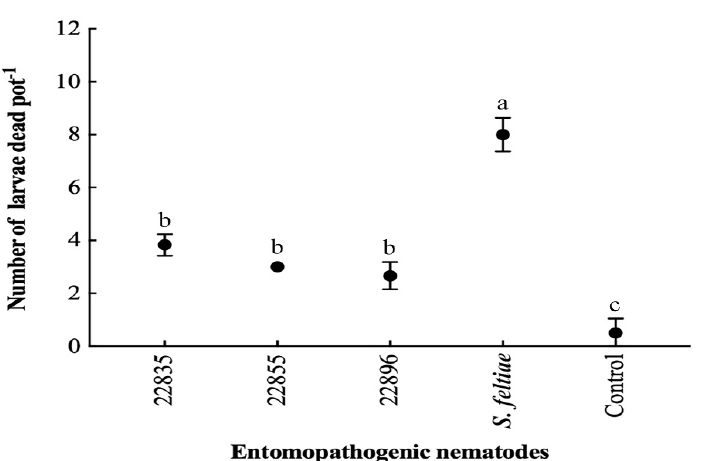
Figure 7. Mean number of dead larvae of the third-instar Spodoptera frugiperda in pot experiments after five days of different treatments (4800 IJs plant − 1 ). Bars with different letters represent signifi- cant differences between treatments by Tukey’s test ( p < 0.05). S. feltiae : Steinernema feltiae ;